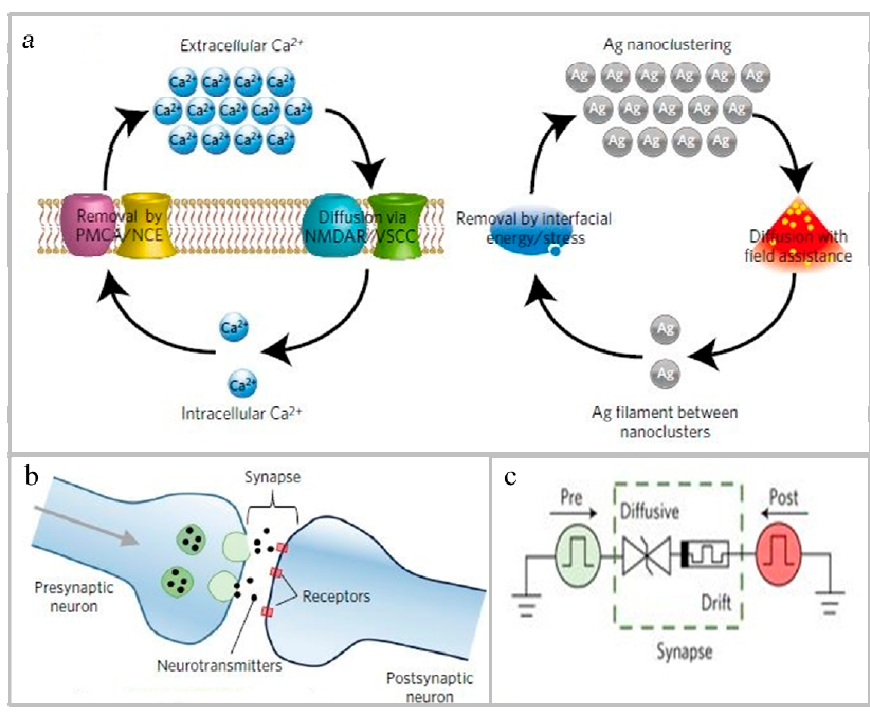
Figure 5. Resistive random-access memory (RRAM) that mimics synaptic memory. ( a ) Schematic illustration of the analogy between Ca 2+ and Ag dynamics. ( b ) Illustration of biological synaptic connections between presynaptic and postsynaptic neurons and circuit diagrams of electrical synapses [135]. Copyright 2016, Nat. Mater.